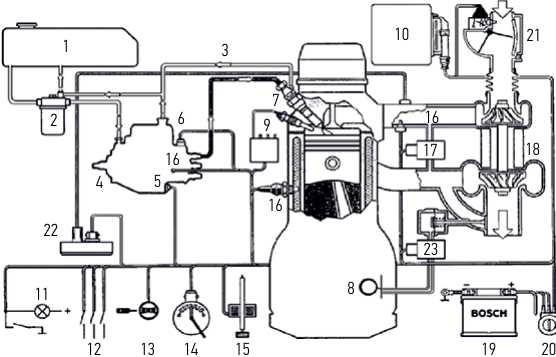
Fig. 1. Scheme of 1Z TDI engine and its control system: 1 – fuel tank; 2 – fuel filter; 3 – feedback fuel line; 4 – high pressure fuel pump; 5 – injection phase corrector; 6 – fuel electromagnetic valve; 7 – nozzle with an injection duration sensor; 8 – vacuum pump; 9 – heating candle; 10 – ECS; 11 – diagnostic lamp; 12 – clutch, brake and engine brake switches; 13 – resolution and upper rest point sensor; 14 – accelerator potentiometer; 15 – speed sensor; 16 – temperature detectors; 17 – electro- pneumatic exhaust gas recirculation valve; 18 – turbocompres- sor; 19 – accumulator battery; 20 – starting switch; 21 – air debit gauge; 22 – sensor of pressure injection in the collector; 23 – turbocompressor control